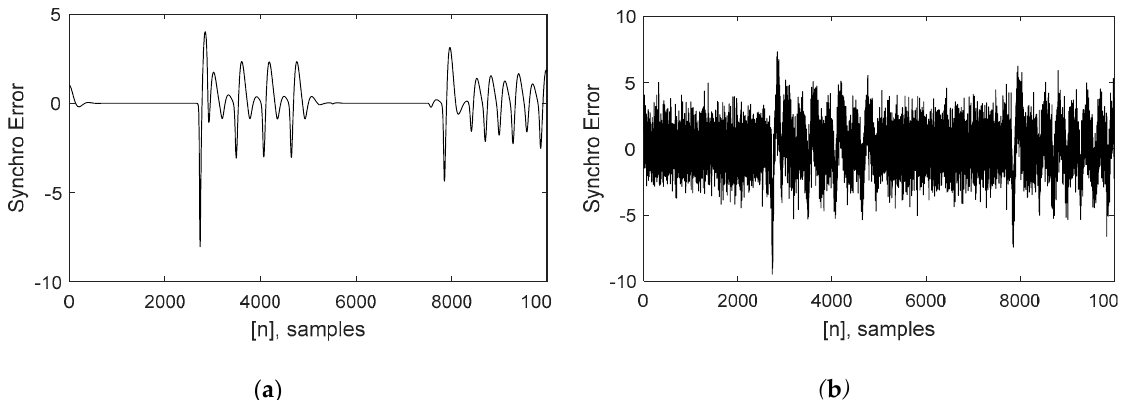
Figure 3. Master-slave synchronization error with ideal ( a ) and noisy ( b ) synchronization signal. Figure 4. Correct message recognition in ideal channel ( a ) and incorrect recognition in noised channel (SNR = 5dB) ( b ).